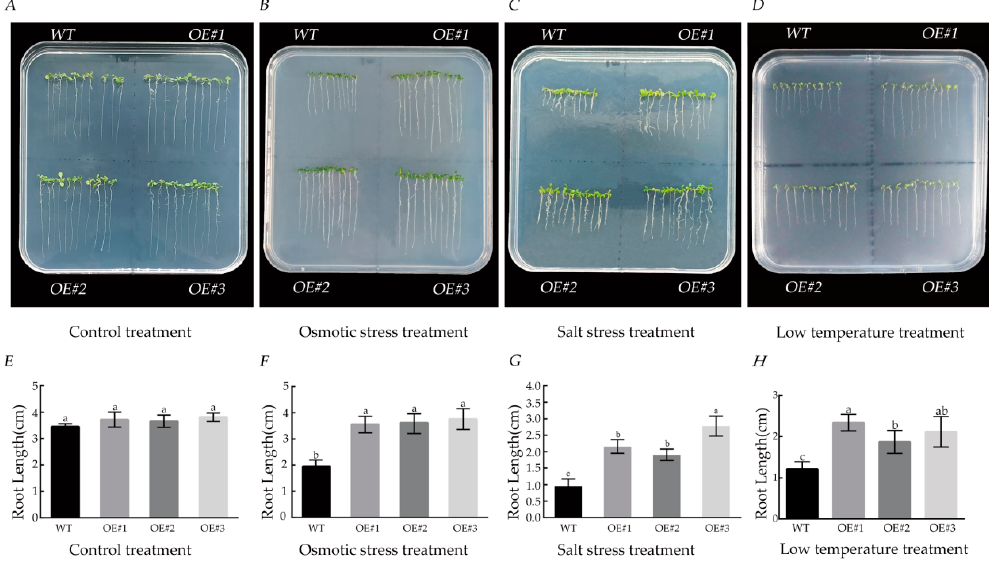
Figure 12. Effects of different stress treatments on the root length of Arabidopsis thaliana ( A , E ) half MS Petri dish. ( B , F )—Half MS Petri dish containing 250 mM mannitol treatment. ( C , G )—Half MS petri dish containing 150 mM NaCl treatment. ( D , H )—Half MS petri dish treated at a low temperature of 4 ◦ C. Bars with different letters “a, b, c” above the columns indicate significant differences ( p < 0.05, Duncan’s range test) on a given day of